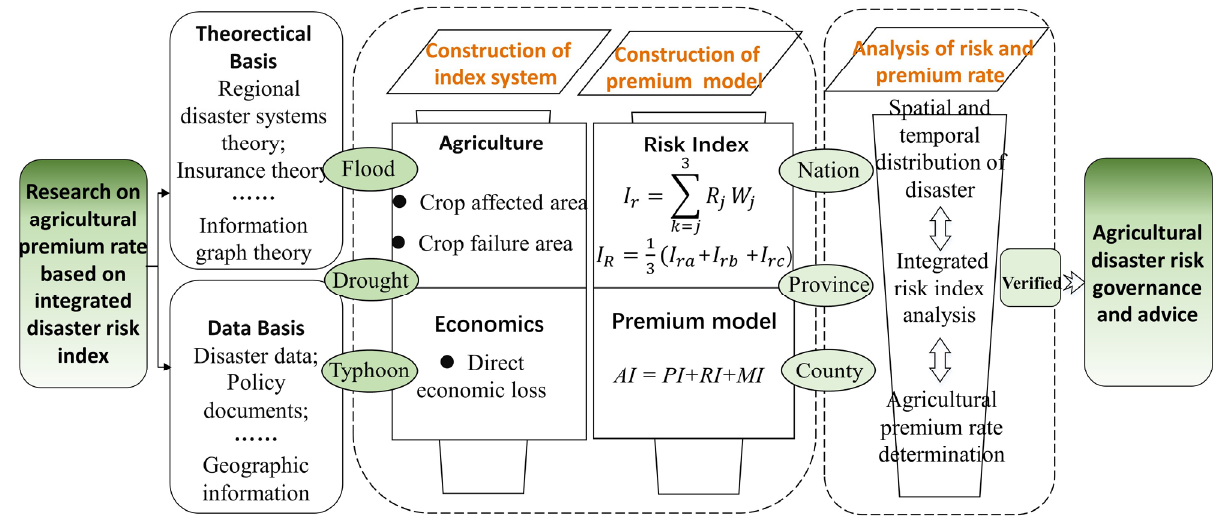
Figure 1. Research framework of agricultural premium rate based on disaster risk index.